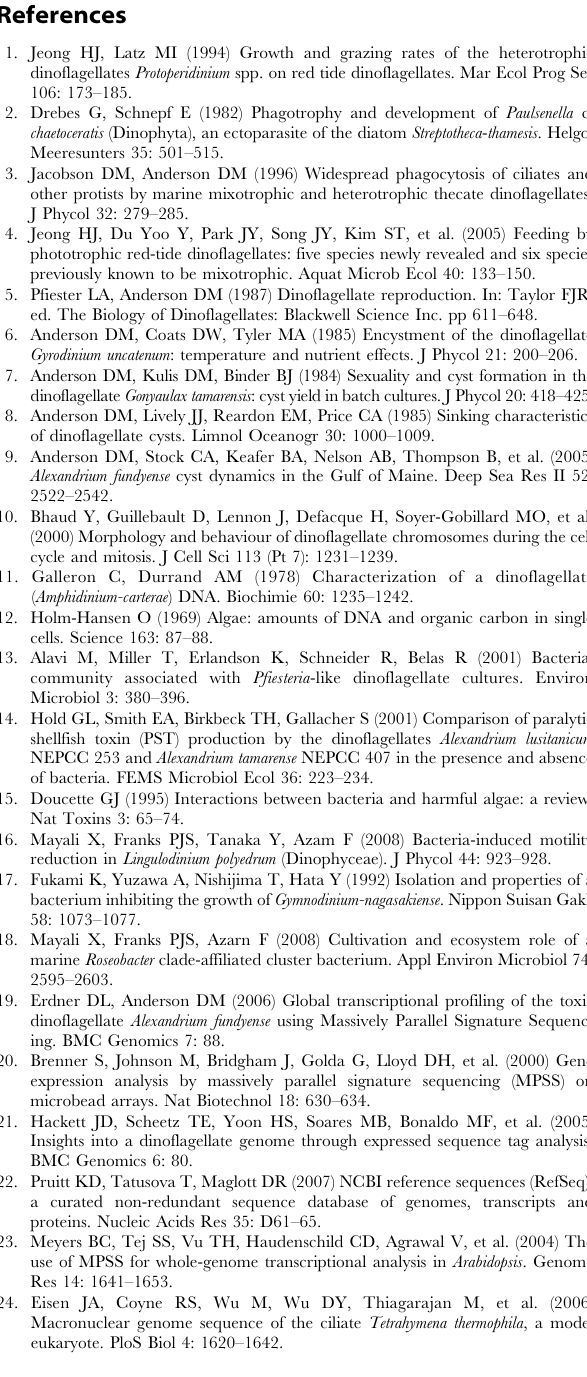
Figure S2 The unique set of Alexandrium MPSS signatures derived from this work and their expression levels under the different culture conditions that were